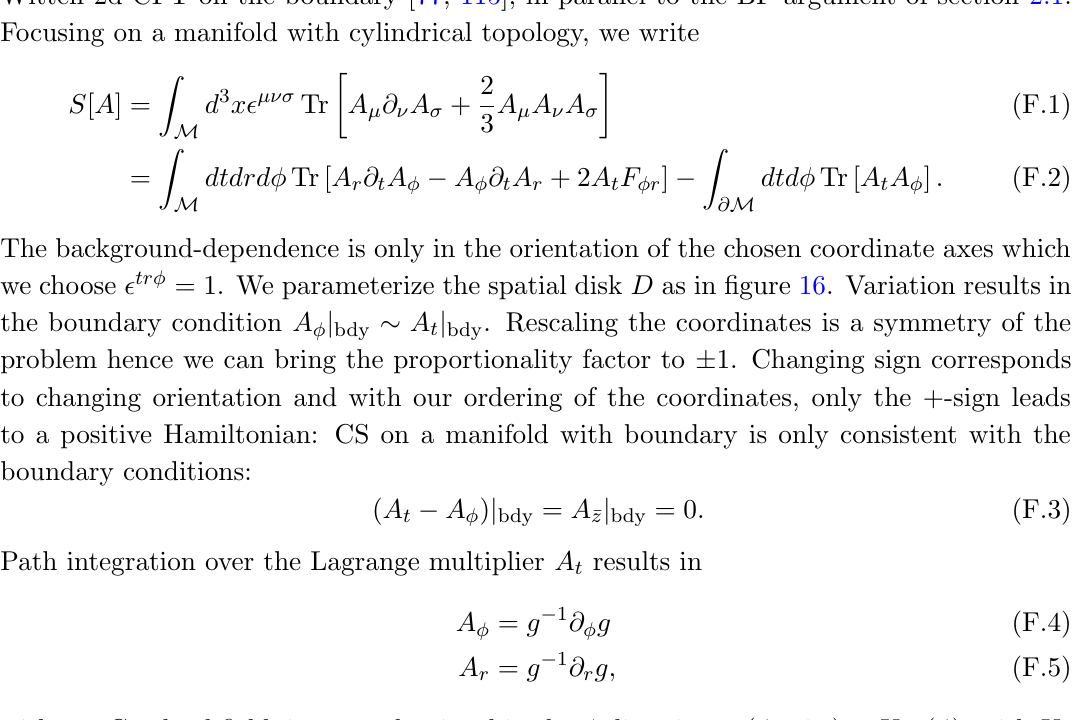
R into a boundaryless ×